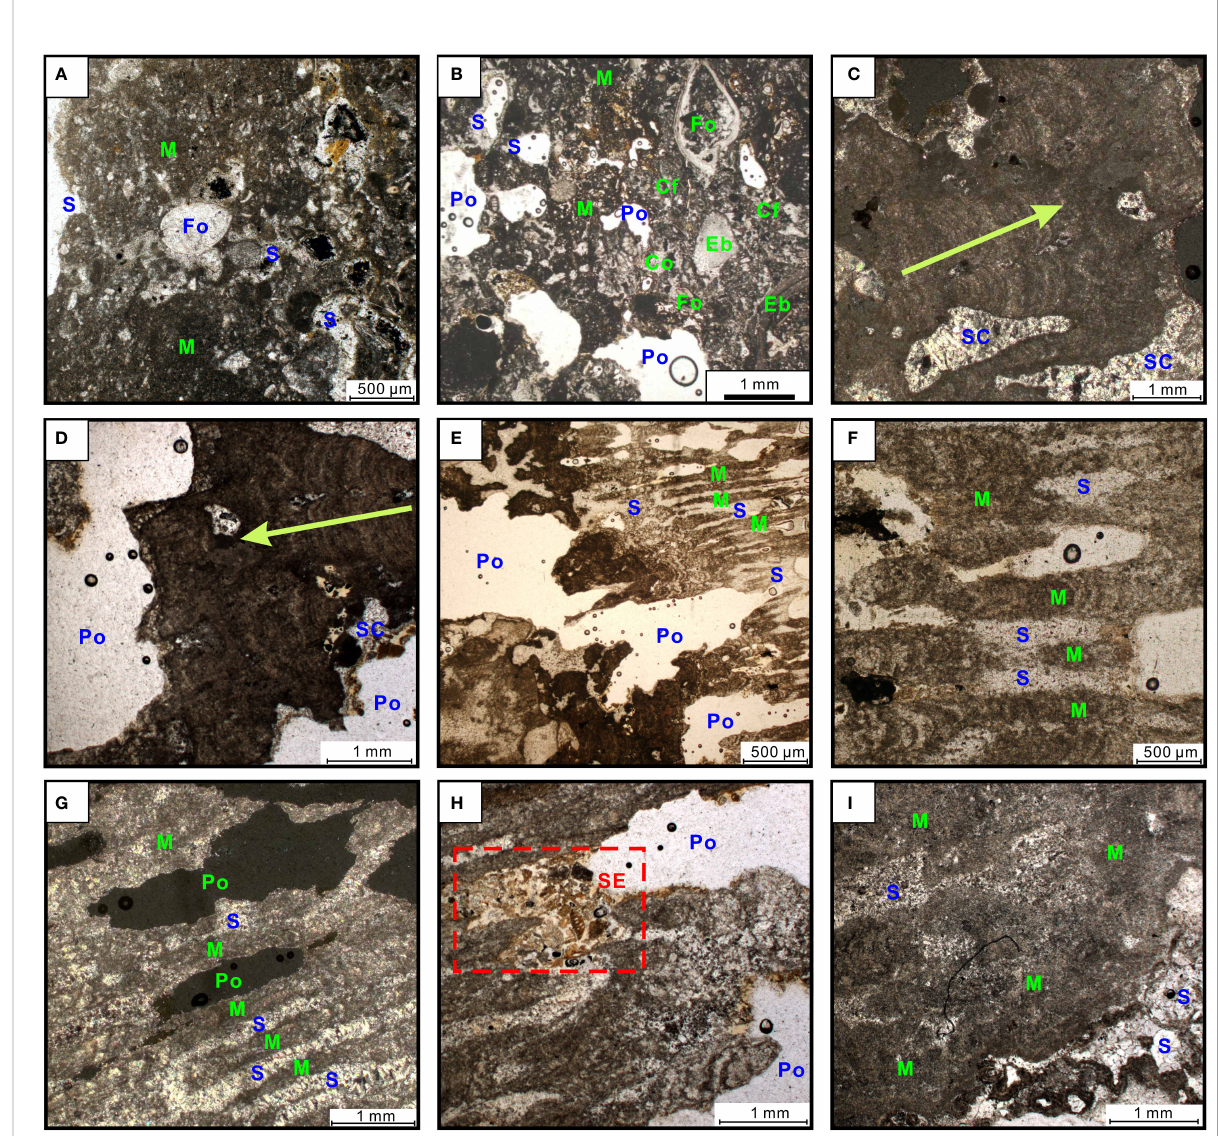
FIGURE 4 Thin-section micrographs of sample Bh116. (A, B) Micritic areas with sparite, foraminifera, echinoderm brachiopods, coral fragments, and pore structure in Bh116s1. (C, D) Laminated microcrystalline fabric structure with secondary cement and pores. The arrows show the growth direction. (E – G) Microcrystalline and sparite crystals alternating with fabric microporous calcite. (H, I) Sediments and sparite in the margin of the pores (see Figure 3 for the locations of the thin